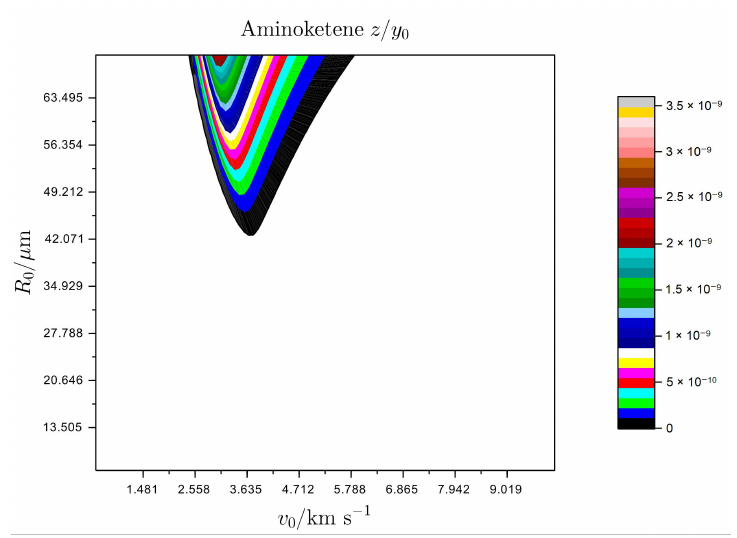
Figure 12. Contour lines of the relative concentration of aminoketene z / y 0 (3.26 × 10 − 10 ≤ z / y 0 ≤ 3.26 × 10 − 9 ) calculated with L = 1.3 × 10 − 11 m, D 0 = 1.0 × 10 − 12 m 2 s − 1 , and θ 0 = 45.0 deg versus the initial velocity and radius of micrometeoroids with 0.5 ≤ v 0 ≤ 10.0 km s − 1 and 7 ≤ R 0 ≤ 70 µ m.